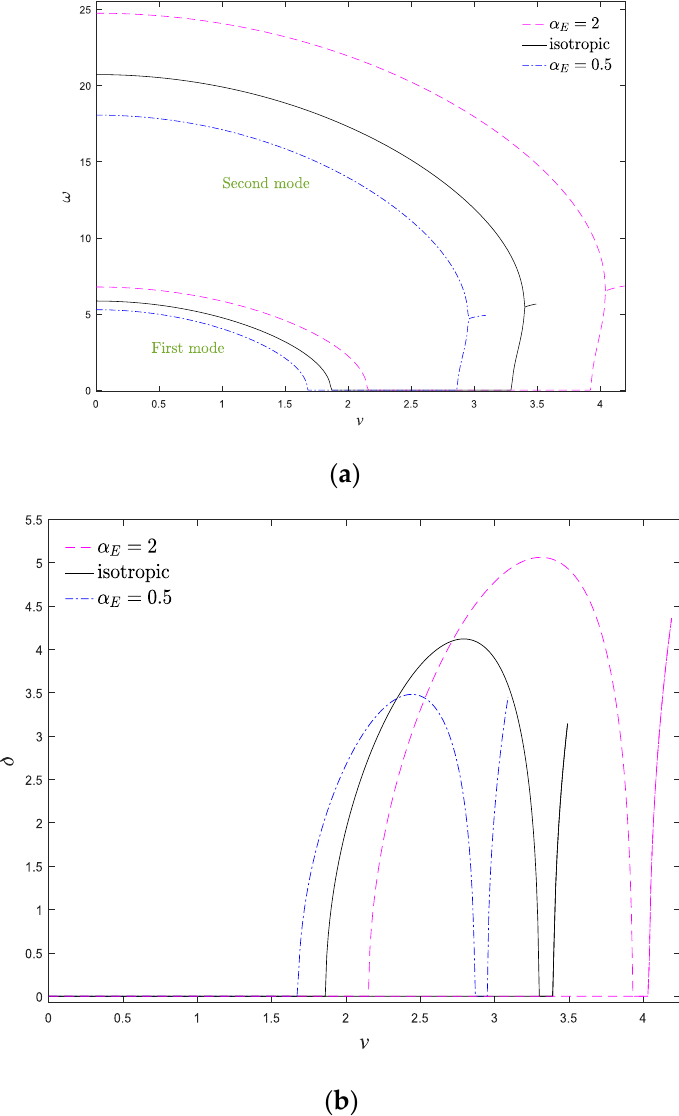
Figure 6. ( a ) Real and ( b ) imaginary parts of two first dimensionless natural frequency of the system against the dimensionless axial velocity for ζ = 0, α ρ = 1, k f = 0.5, µ = 0, k = 1.